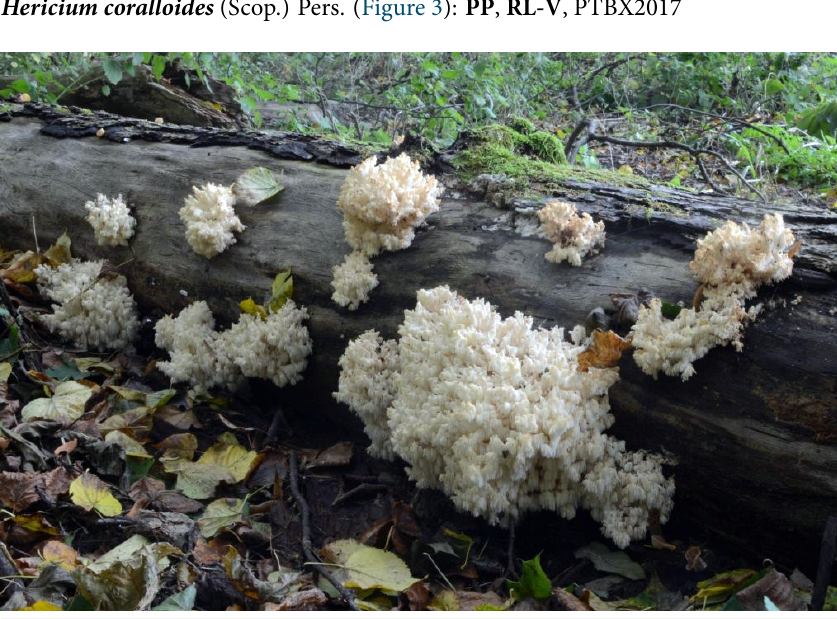
Figure 3 Hericium coralloides . Photo by B.